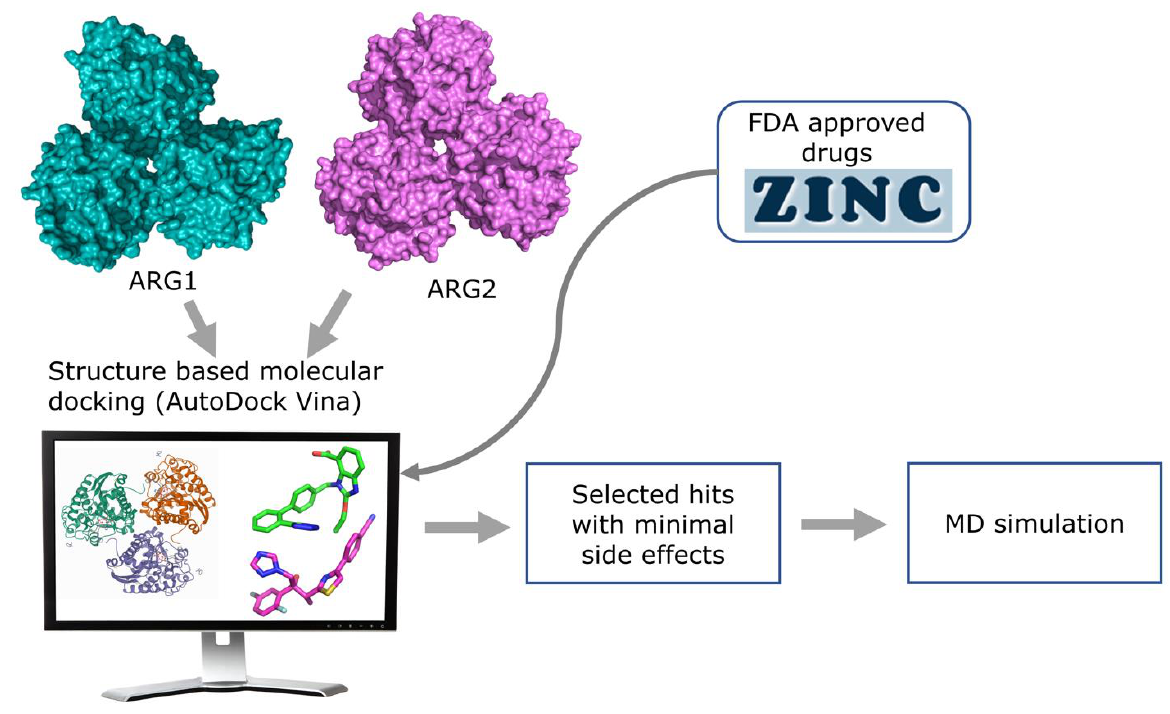
Figure 3. Overview of the structure-based virtual screening workflow.